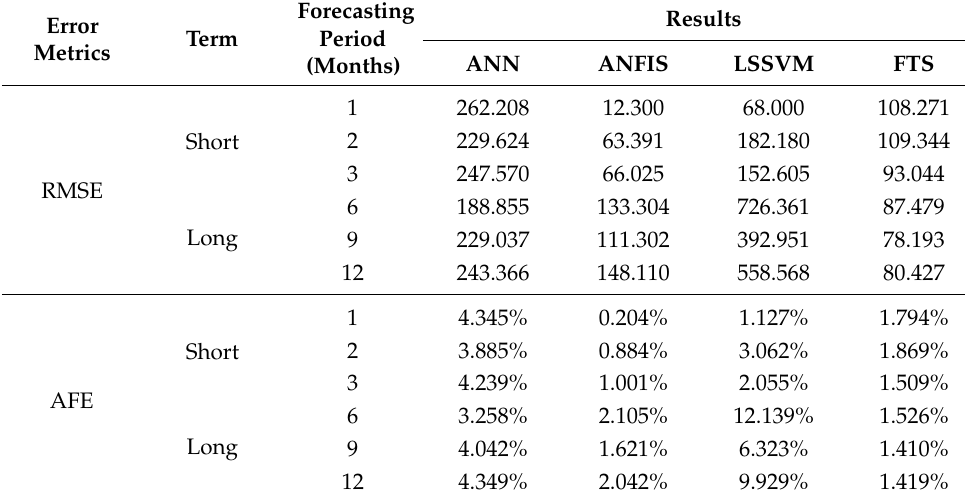
Table 6. Short-term and long-term forecasting results for Switzerland.